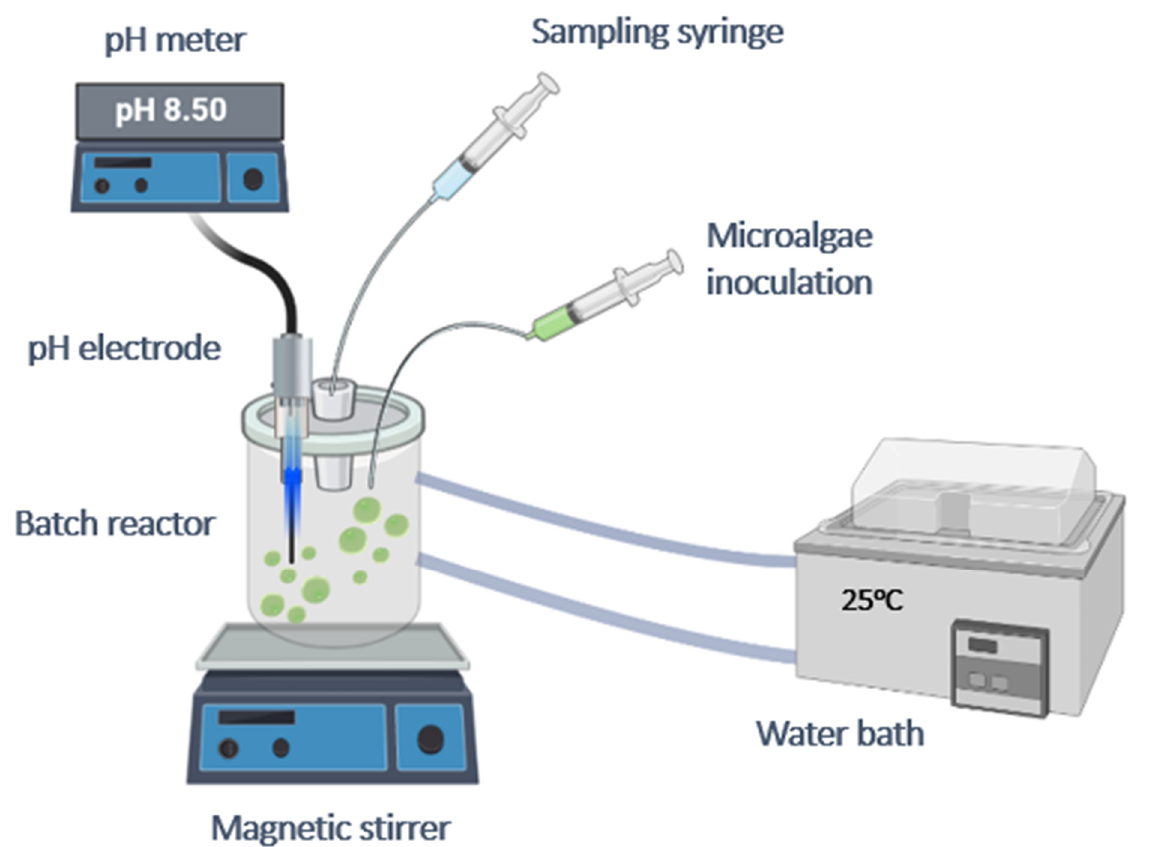
Figure 1. Experimental setup for the study of mineralization and adsorption of HM on solids